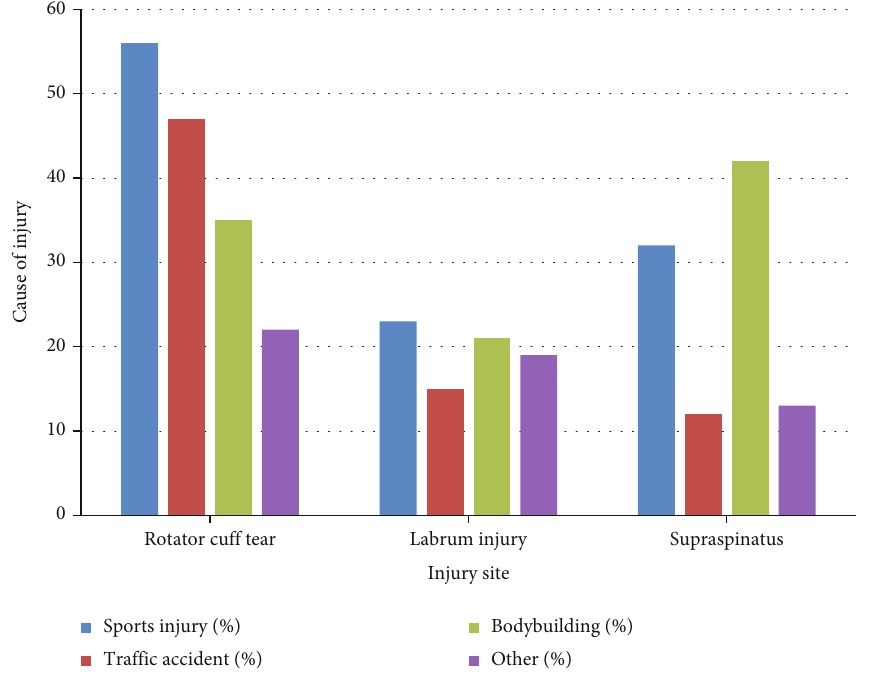
Figure 8: Comparison of the causes of shoulder joint